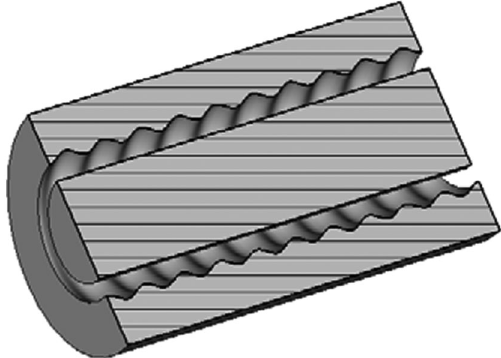
FIG. 1. Schematic diagram of a coaxial electrostatic wiggler, which is performed by a coaxial structure: the outside surface of the inner rod is smooth and grounded; the inside surface of the outer conductor is connected to a negative voltage and corru- gated with sinusoidal